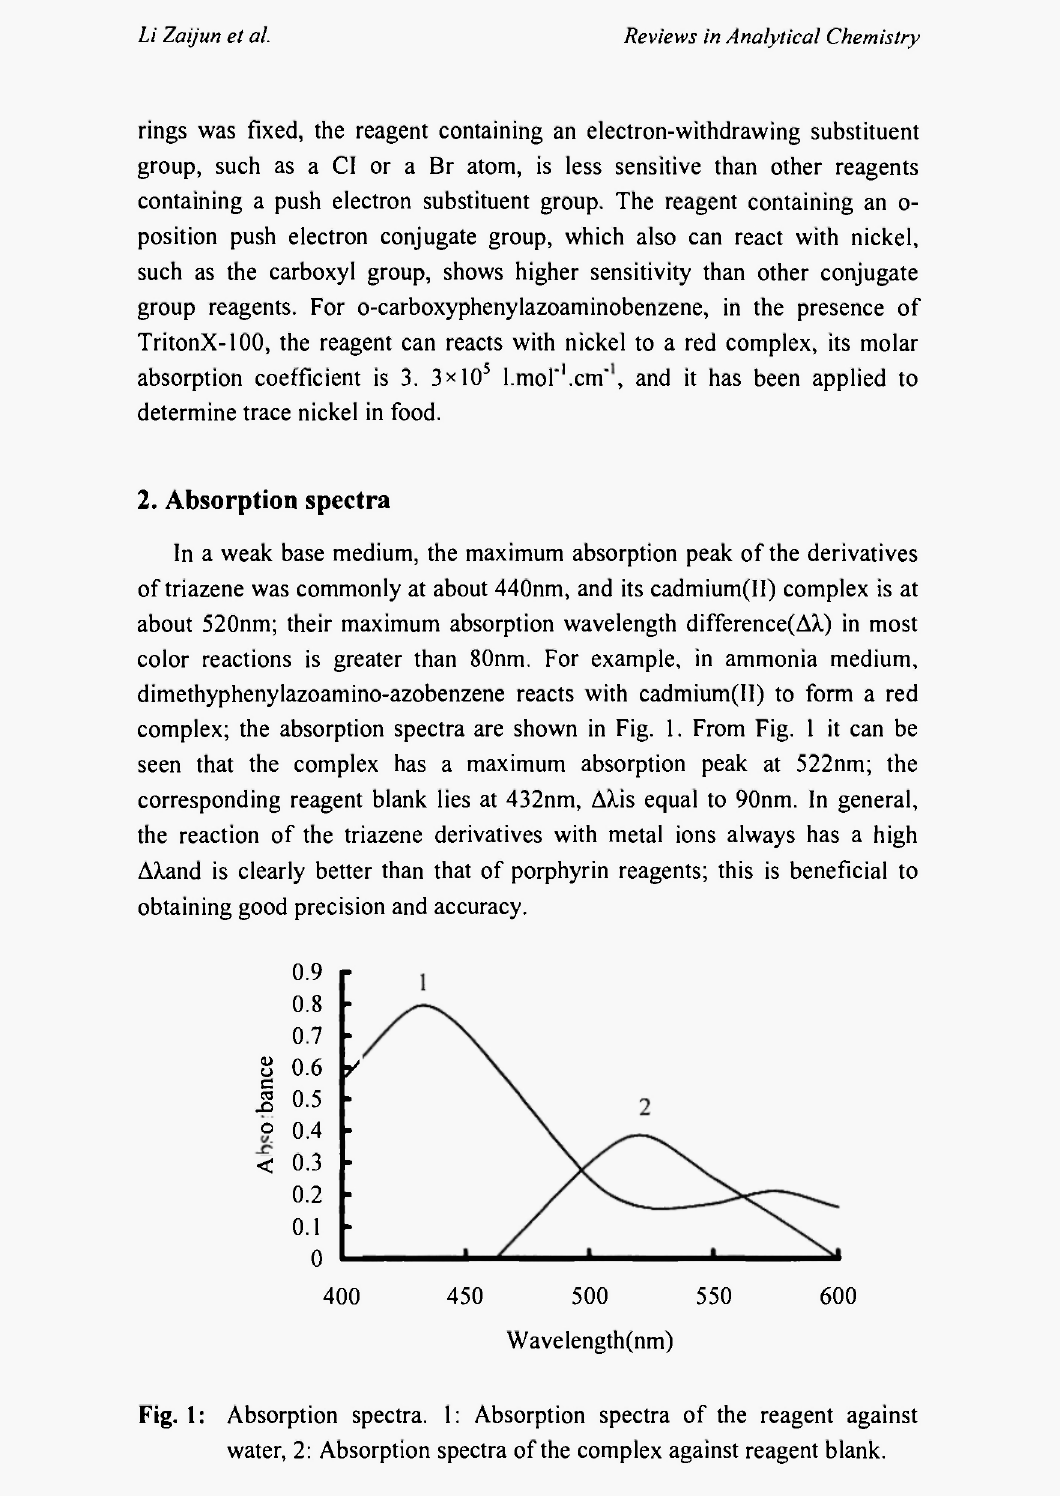
Fig. 1: Absorption spectra. 1: Absorption spectra of the reagent against water, 2: Absorption spectra of the complex against reagent